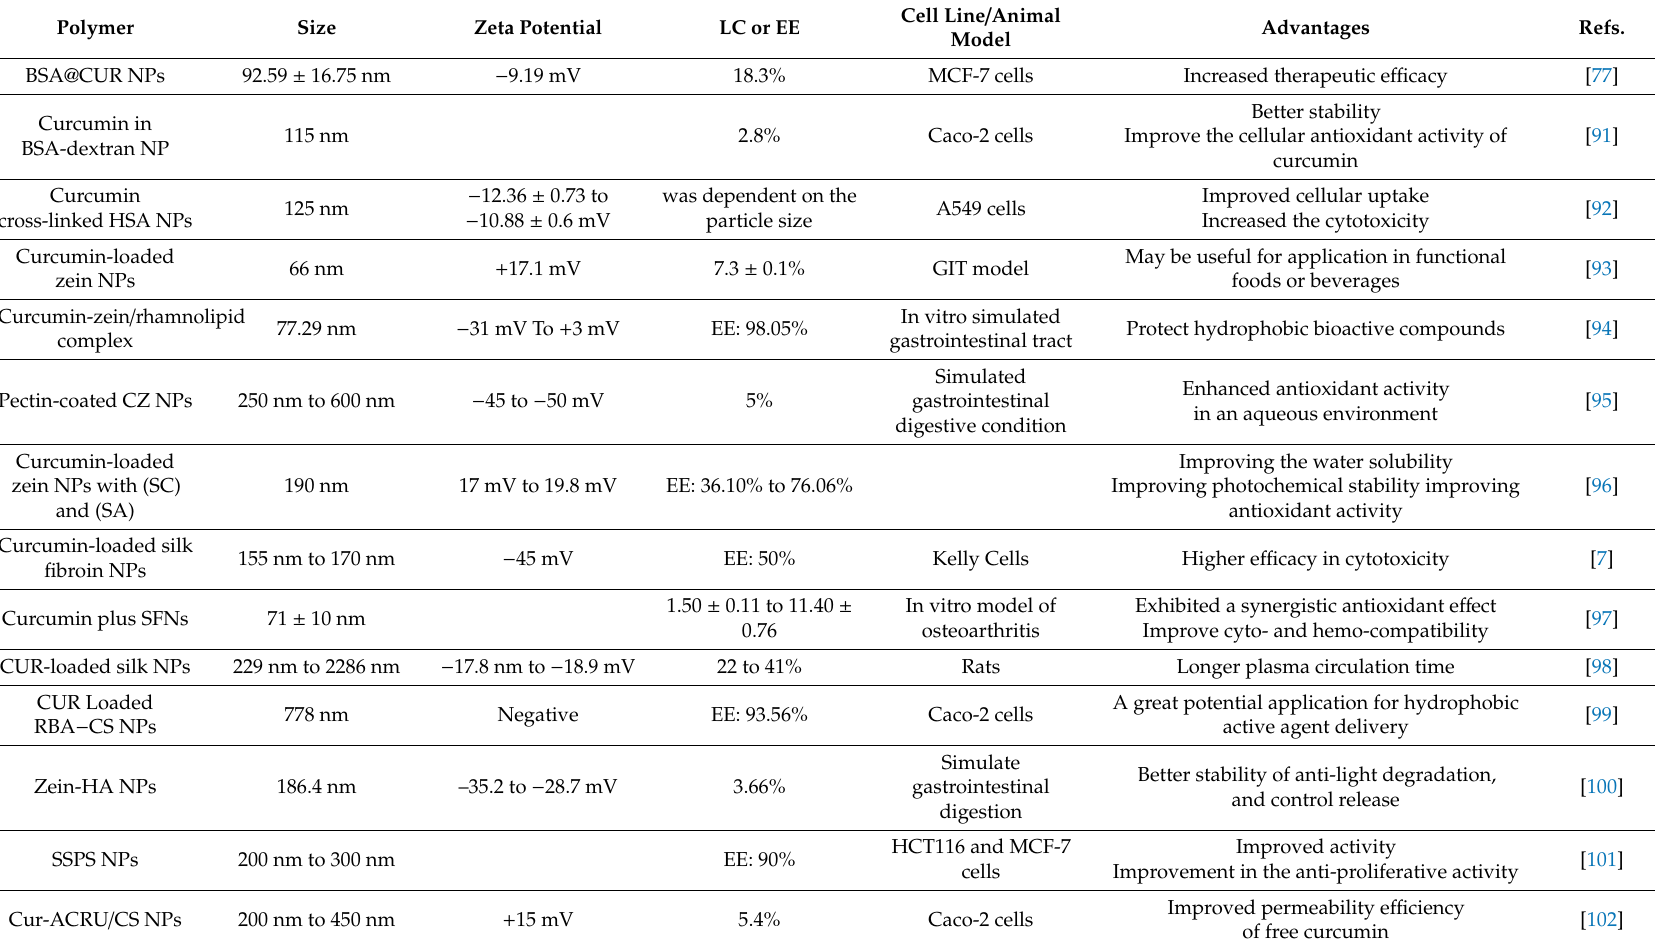
Table 1. A list of di ff erent curcumin nanocarriers with their characteristics and applications under in vitro and in vivo